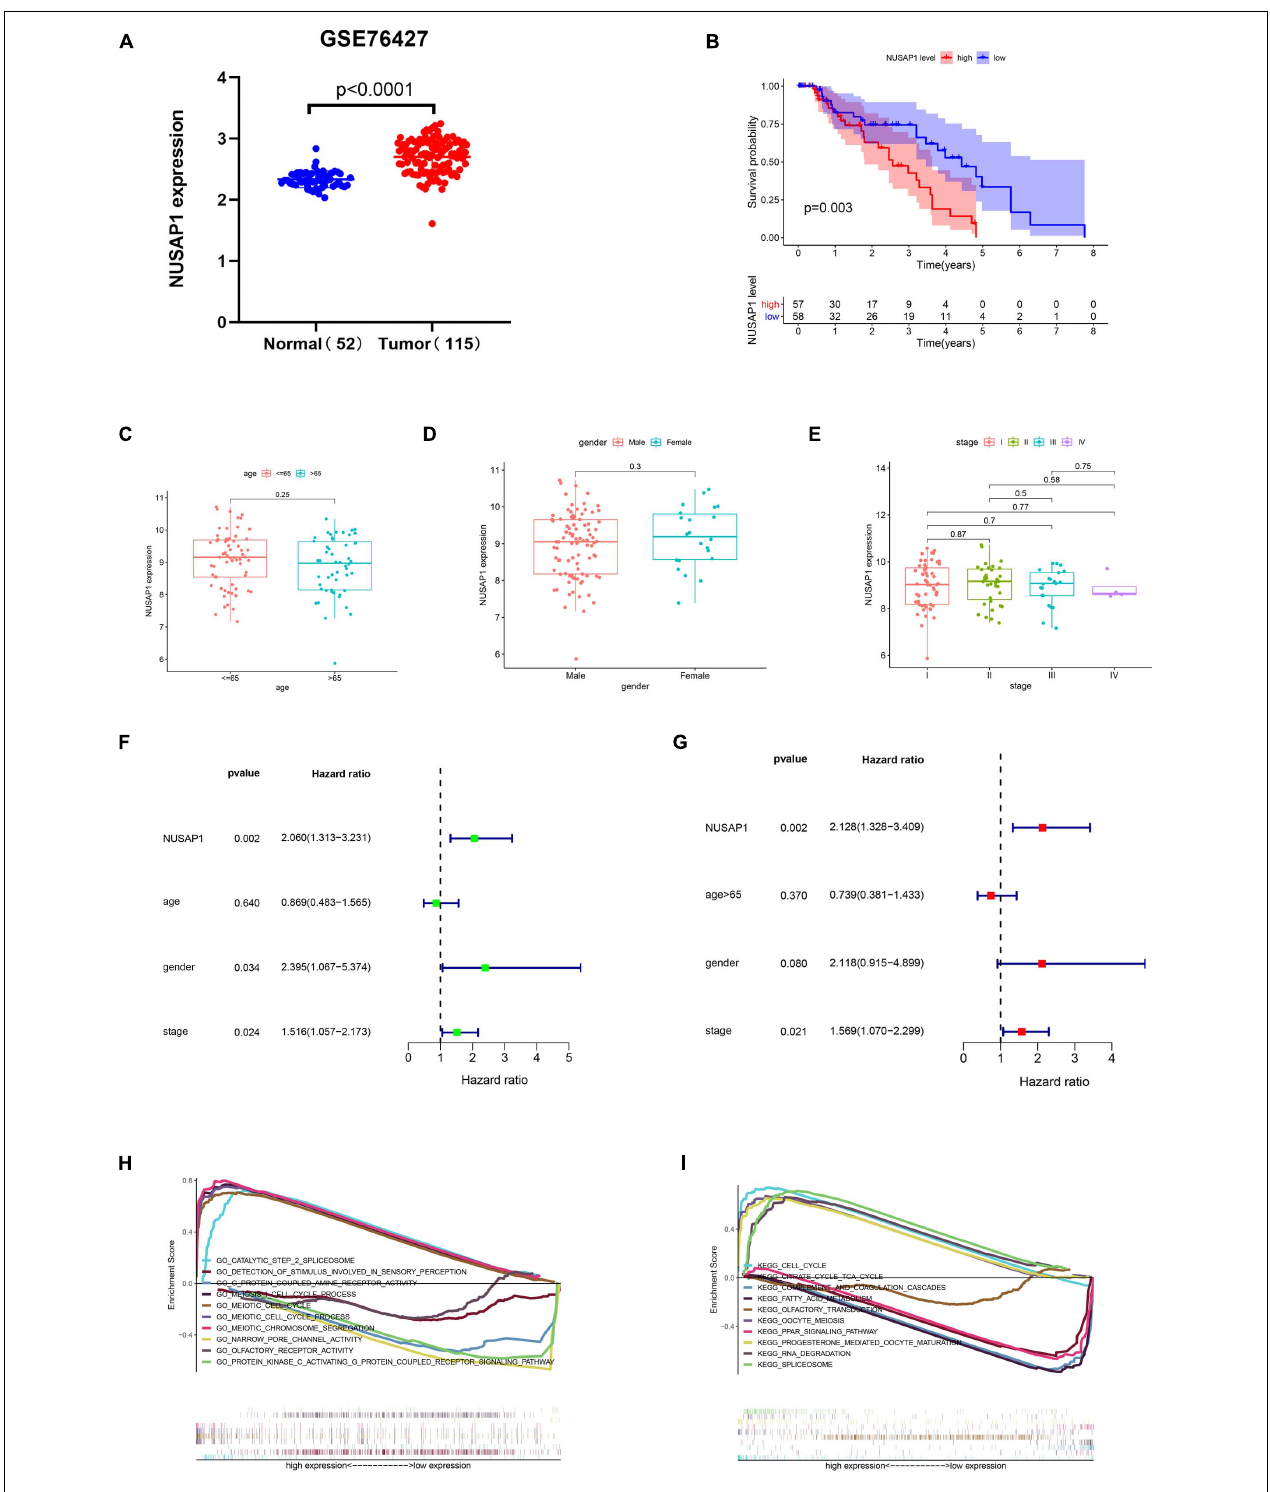
FIGURE 3 | Dot plot, Kaplan–Meier curve, box plots, forest plots, and GSEA enrichment analysis. All pictures were made by HCC patients’ expression and clinical information in GSE76427 dataset. (A) Dot plot of NUSAP1 expression in normal samples and HCC samples. (B) Kaplan–Meier curve of OS analyzed between high NUSAP1 expression group and low expression group. (C) Bar graph of NUSAP1 expression in different age groups. (D) Bar graph of NUSAP1 expression in female and male. (E) Bar graph of NUSAP1 expression in different stage groups. (F) Univariate regression analysis. (G) Multivariate regression analysis. (H) GSEA enrichment analysis, which was based on GO gene sets. (I) GSEA enrichment analysis, which was based on KEGG gene sets.